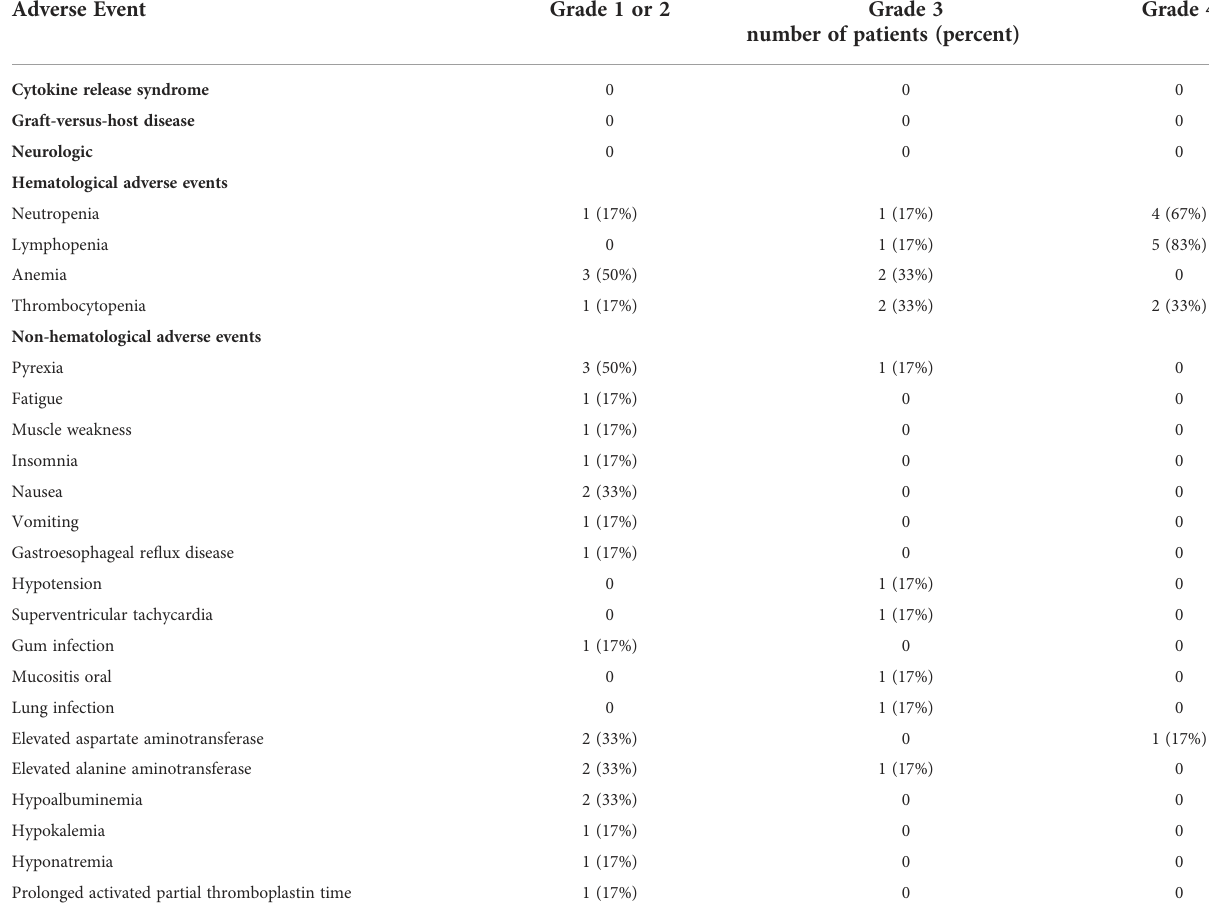
TABLE 2 Adverse events in the 6 study